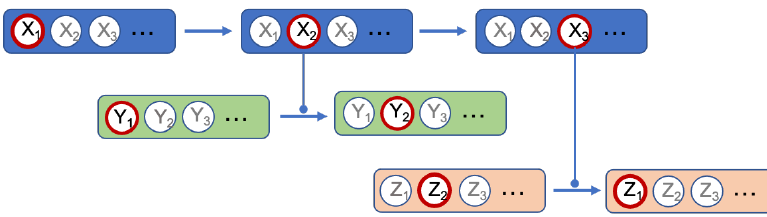
Figure 2. Example of a component having multiple active